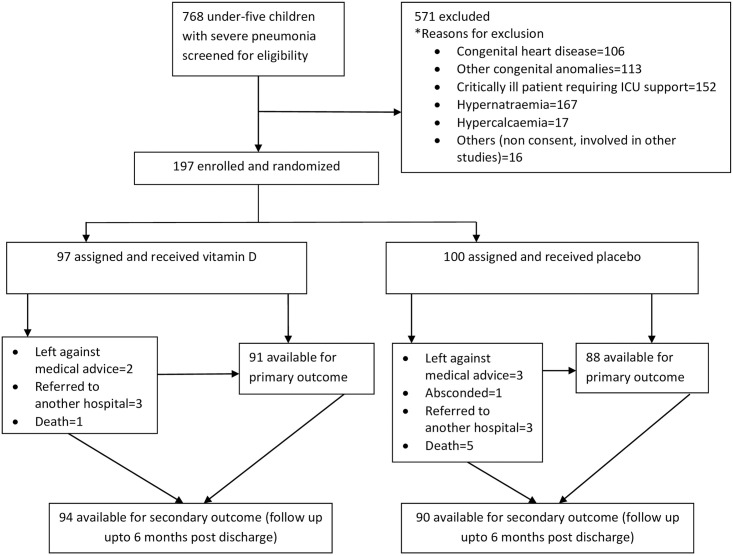
Vitamin D trial profile showing participant enrollment.